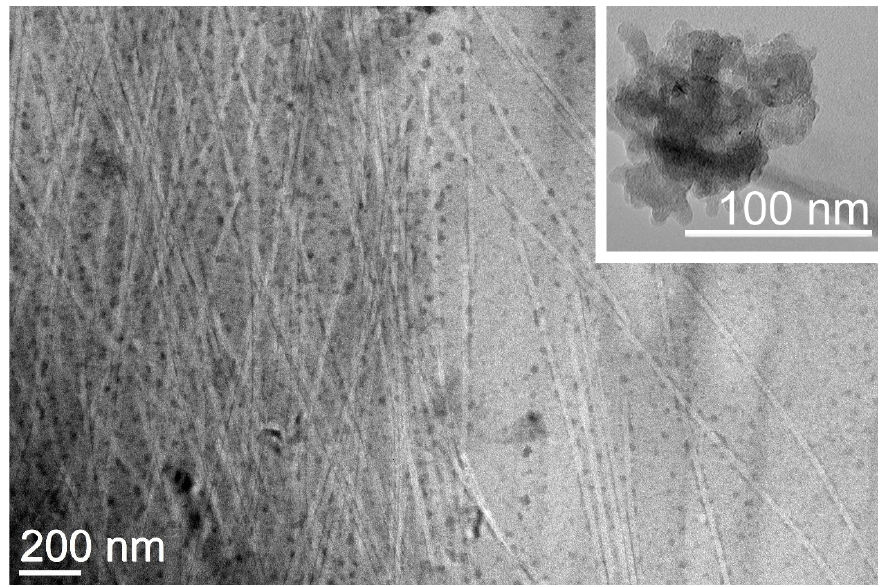
Figure 5. TEM micrograph of the nanocomposite supramolecular hydrogel formed by Lff in the presence of oxi-CNOs through the non-covalent approach. Inset figure shows aggregate of oxi-CNOs in the absence of the Lff peptide.